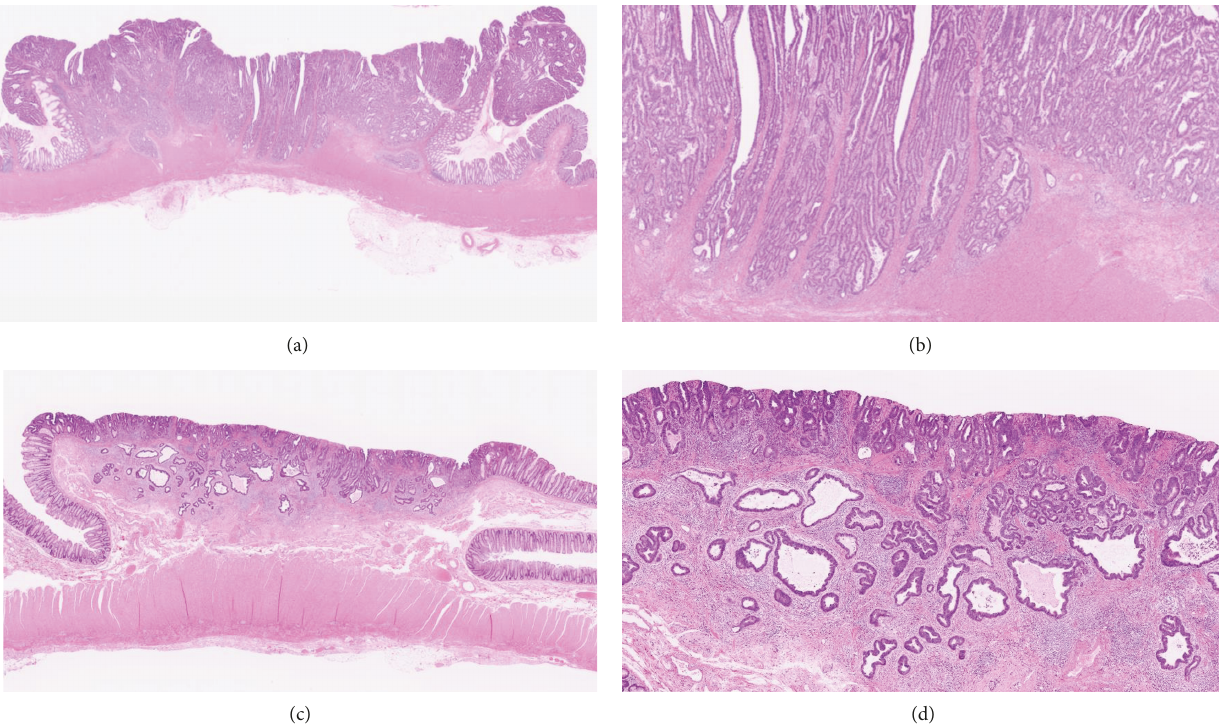
Figure 1: Case presentation of pure well-di ff erentiated adenocarcinoma (PWDA). (a, b) A case of T2 cancer with PWDA. Histology of the surgically resected specimen. The histological diagnosis was T2 cancer constructed only of well-di ff erentiated adenocarcinoma. (c, d) A case of T1 cancer with PDWA. Histology of the surgically resected specimen. The histological diagnosis was T1 cancer constructed only of well-di ff erentiated adenocarcinoma